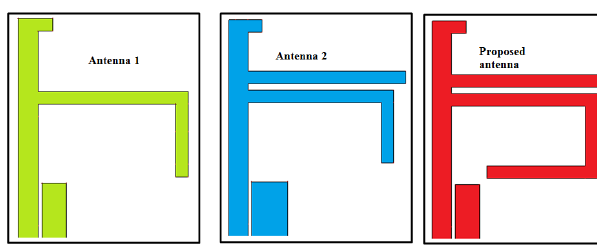
Figure 2: Evolution process of the tri-band monopole an-